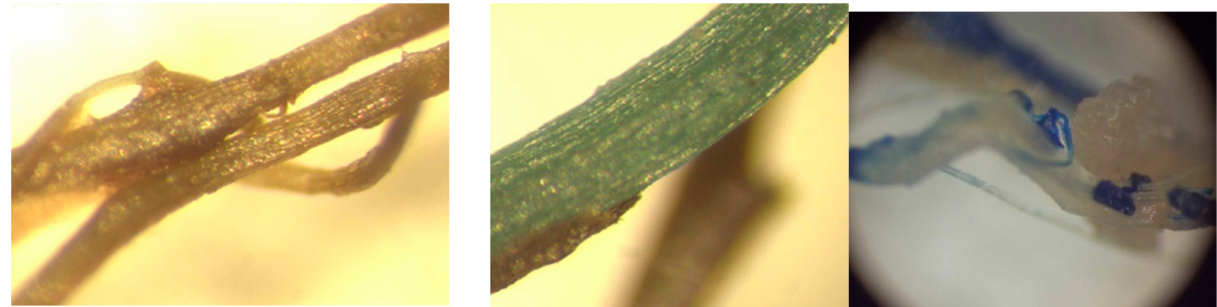
Figure 5. Arbuscular mycorrhizal fungi (AMF) inoculation measurement. Blue colored roots indicate the colonization of